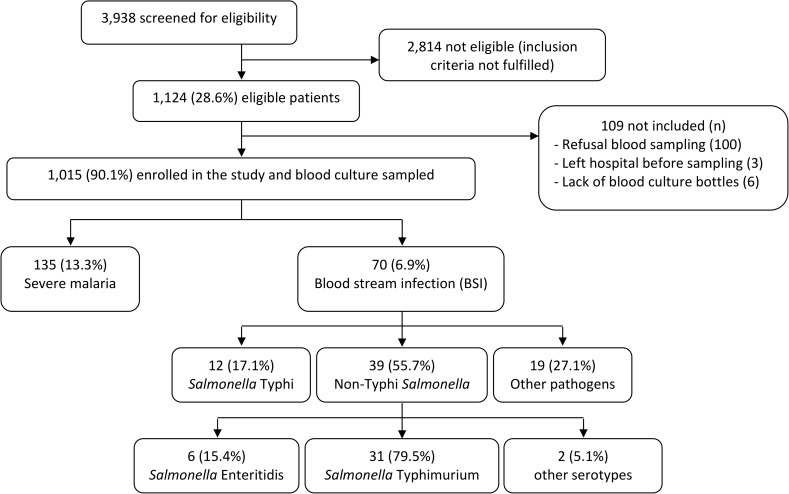
Patients’ flow for the patients within the HDSS catchment area and for both inclusion sites.One grown blood culture contained 2 isolates.